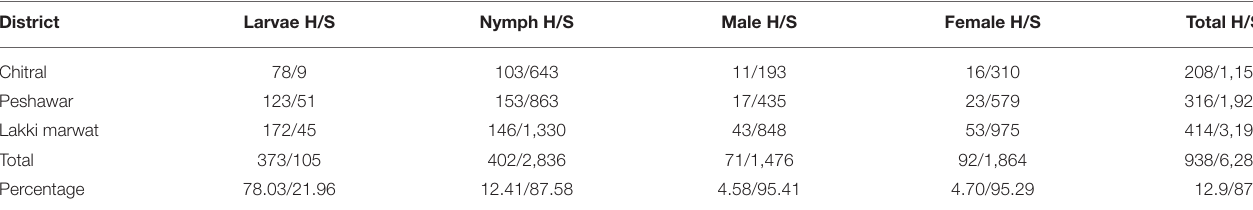
TABLE 2 | Number of collected Argas persicus ticks according to domestic fowl hosts (H) and their shelters (S). District Larvae